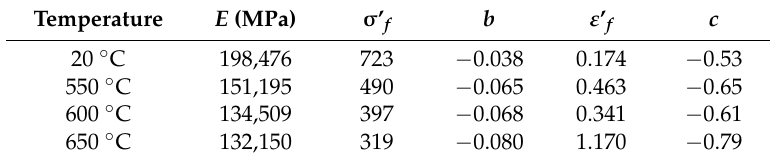
Table 2. Coffin-Manson-Basquin model parameters of P92 steel at different